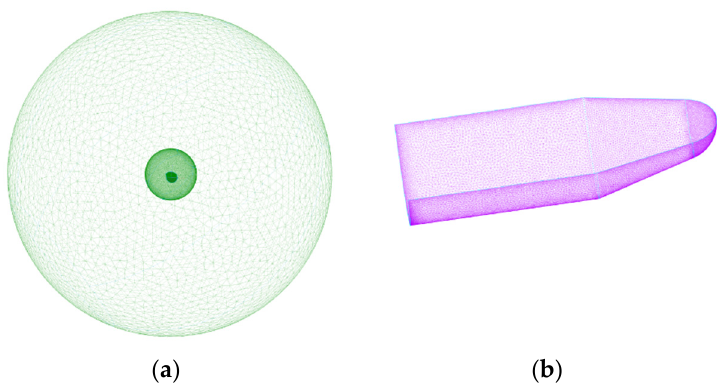
Figure 6. Fluid mesh. ( a ) Global mesh. ( b ) Mesh on the surface of the fairing.